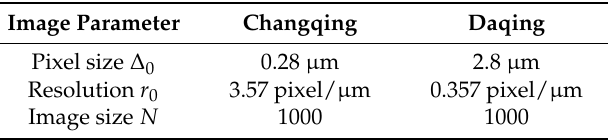
Table 1. Size and resolution of raw